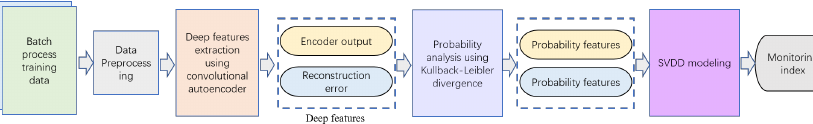
Figure 2. The proposed method framework.